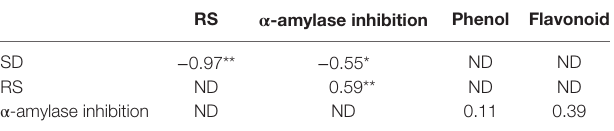
Table 3 | Correlations between SD versus RS and α -amylase inhibition; RS versus α -amylase inhibition; α -amylase inhibition versus total phenol and flavonoid of the food samples.